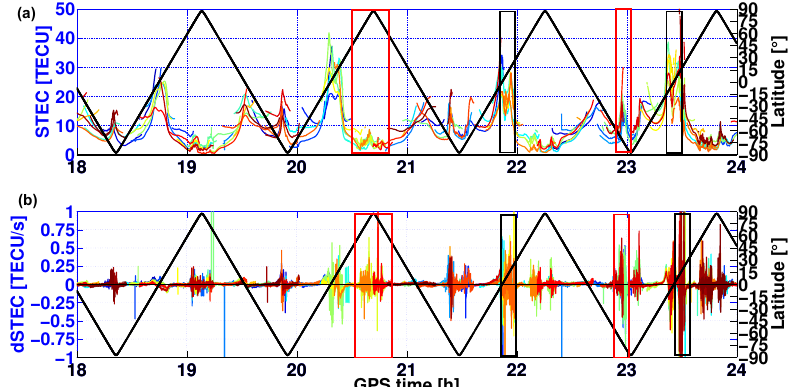
Figure 4. (a) STEC and (b) its rate for Swam A from 18:00 to 24:00 on DoY, 333, 2015. The right legend shows the geographic latitude.